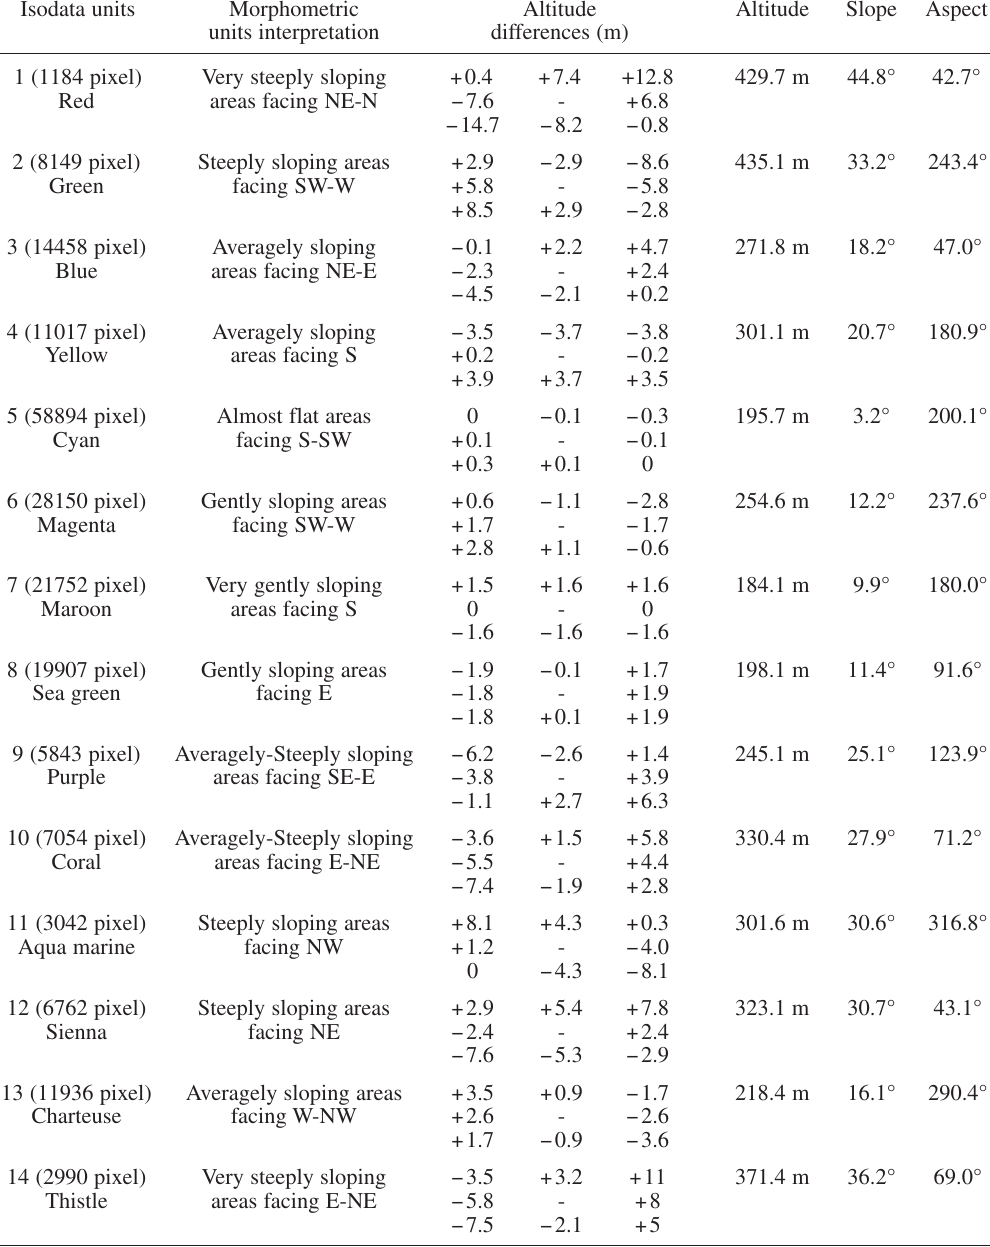
Table III. Altitude, slope and aspect mean values and morphostructural interpretation of the elevation differ- ences between each pixel and the eight neighbours, for the 14 classes obtained by applying ISODATA cluster- ing method to the study